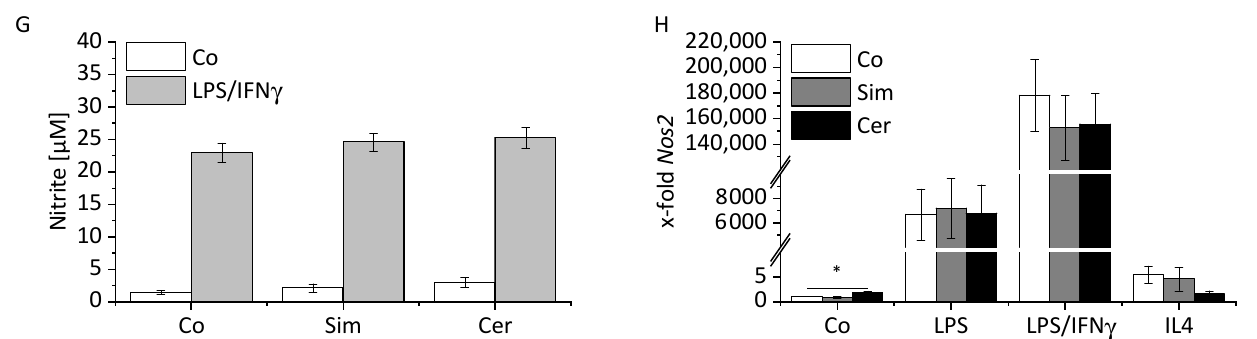
Figure 1. Effect of statin treatment on inflammatory macrophage activation. ( A ) RAW-Blue TM cells were treated with either simvastatin (Sim, 2 µ M) or cerivastatin (Cer, 1 µ M) for 24 h. Inflammatory activation was induced by treatment with LPS (100 ng/mL) for the final 4 h. NF- κ B/AP-1 activity was determined by secreted embryonic alkaline phosphatase (SEAP) detection. Co = solvent control ( n = 3, triplicates). ( B , D , F , H ) Tnf ( B ), Il1b ( D ), Il6 ( F ), and Nos2 ( H ) mRNA expression in BMMs was determined by real-time RT-PCR, normalized to Ppia , and expressed as x-fold of Co. BMMs were stimulated for the last 4 h with LPS (100 ng/mL) or polarized towards M1 (LPS, 100 ng/mL; IFN γ , 20 ng/mL), or M2 (IL4, 20 ng/mL) in the presence or absence of Sim (2 µ M) or Cer (0.5 µ M) for 24 h. Co = solvent control ( n = 6). ( C , E ) TNF ( C ) and IL1 β ( E ) were measured by bioassay. BMMs were treated for 24 h with either Sim (2 µ M) or Cer (0.5 µ M). Inflammatory activation was induced by treatment with LPS (100 ng/mL for IL1 β , 10 ng/mL for TNF) for the final 4 h. Co = solvent control ( n = 3, duplicates for TNF, triplicates for IL1 β ). ( G ) Nitrite production was measured by Griess assay. BMMs were treated for 24 h with either Sim (2 µ M) or Cer (0.5 µ M). Samples were stimulated for the final 20 h (LPS, 50 ng/mL; IFN γ , 20 ng/mL). Co = solvent control ( n = 3, triplicates). A one-sample t -test followed by a Bonholm post hoc test was used for analyzing gene expression data of the control group. Means of more than two groups were compared by one-way ANOVA with Bonholm post hoc test (normal distribution). * p < 0.05, ** p < 0.01, and *** p <